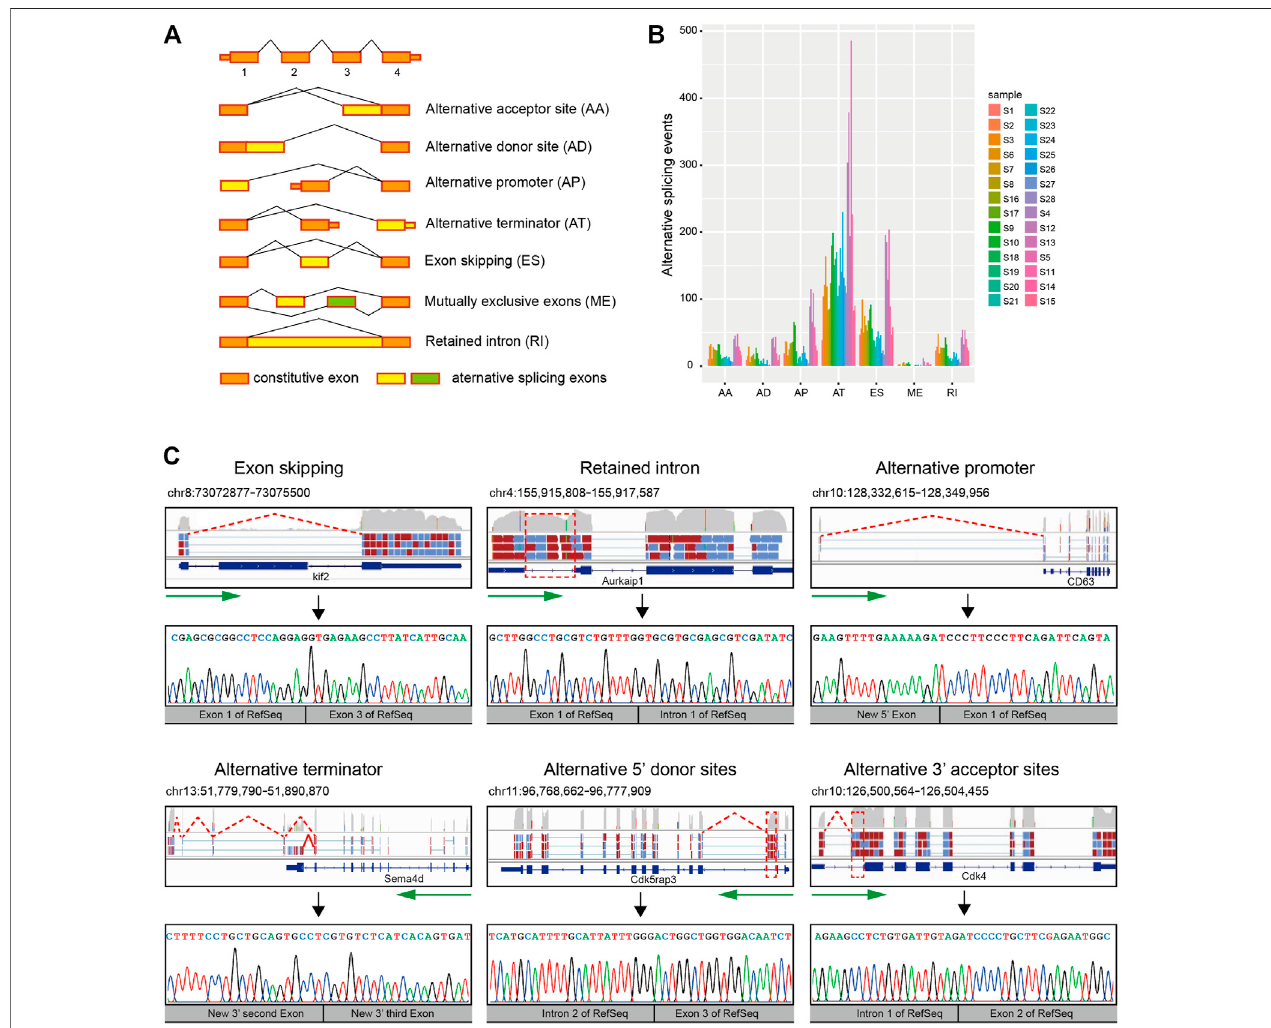
FIGURE 1 | Detection of AS events in the mouse SVZ region by single-cell RNA-seq. (A) A diagrammatic sketch of the seven types of AS events identi fi ed in the present study. (B) Number and type of AS events for 28 single-cell samples. Samples were illustrated according to the cell types. Quiescent stem cells: S1, S2, S3, S6, S7,S8,S16,andS17.Activatedstemcells:S9andS10.Neuroblastcells:S18,S19,S20,S21,S22,S23,S24,S25,S26,S27,andS28.Oligodendrocyte:S4,S12,and S13.Othercells:S5,S11,S14,andS15. (C) Schematicdiagram,visualization,andveri fi cationofsixmajorcategoriesoflocalsplicingpatterns.Schematicdiagram and visualization of six major categories of local splicing patterns (top); arrows in green mark the direction of transcription, and the location of alternative splicing (boxed) are indicated. Veri fi cation of six major categories of local splicing patterns by Sanger sequencing (bottom).